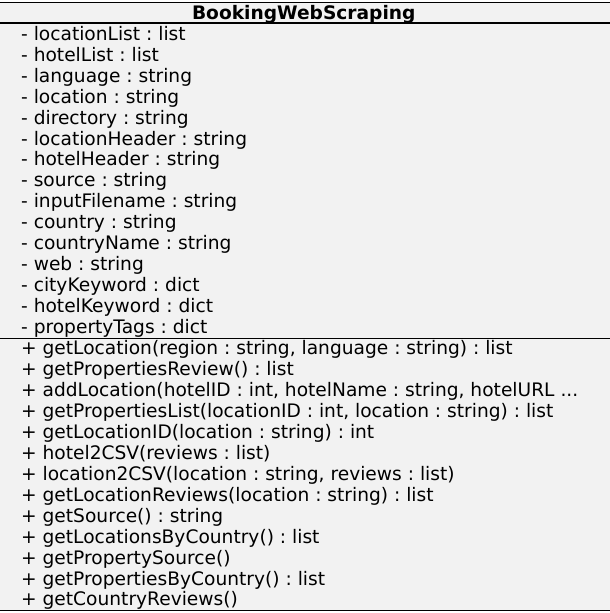
Figure 5. Web scraping class.